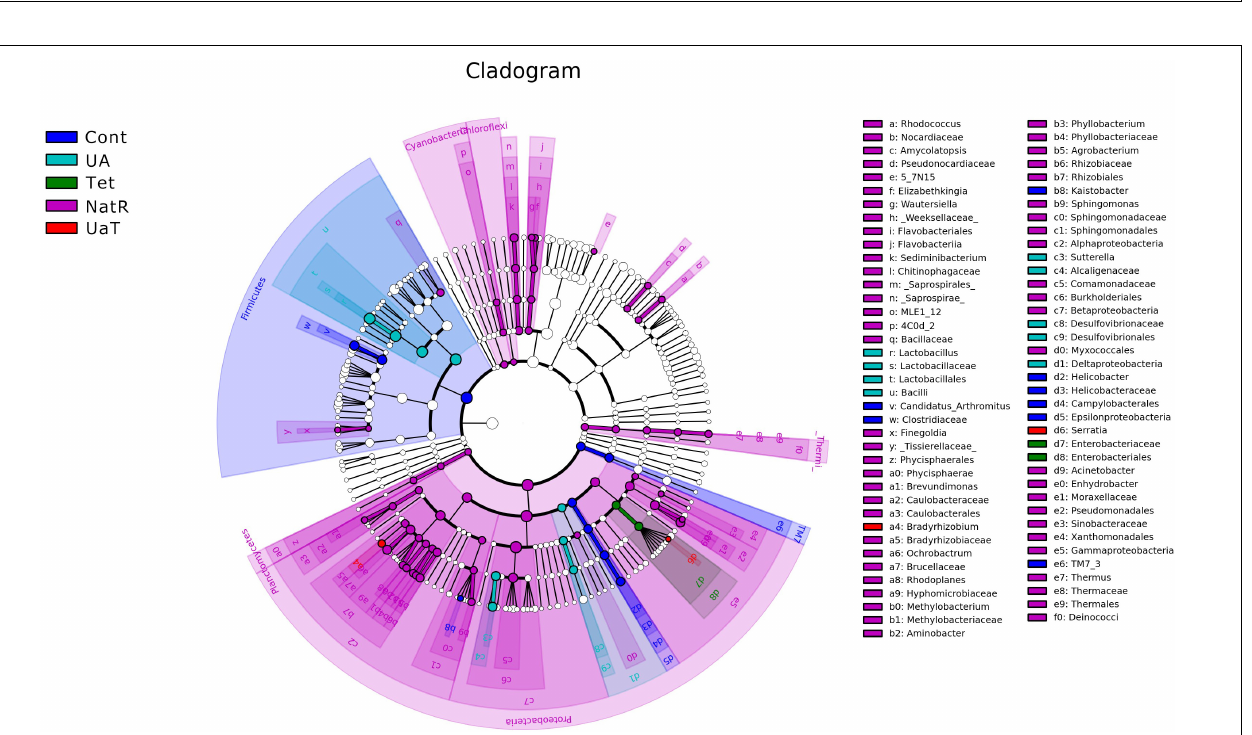
FIGURE 9 | Cladogram of the LEfSe analysis of the gut microbiota in different groups. The microbial compositions were compared at different evolutionary levels. All group names correspond to those described in the legend of Figure 2 .